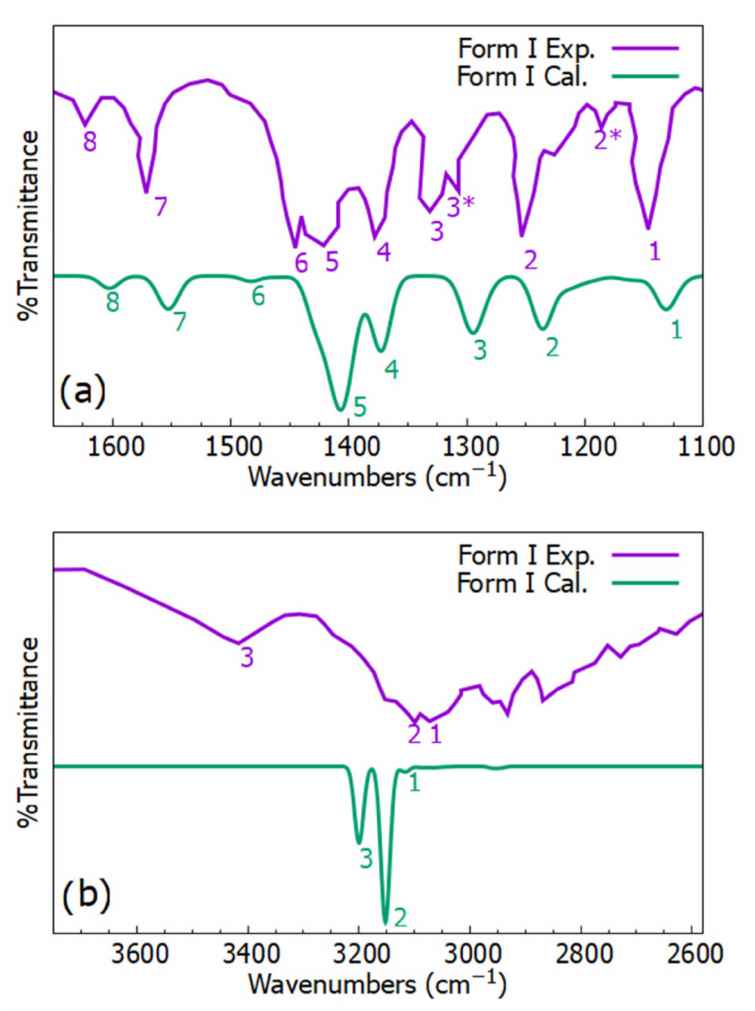
Figure 4. FT-IR spectra of triclabendazole form I at frequencies ( a ) from 1100 cm − 1 to 1600 cm − 1 and ( b ) from 2600 cm − 1 to 3600 cm − 1 . The purple curve represents experimental (Exp.) results [12] which were conducted at atmospheric pressure and room temperature. The green curve represents calculated (Cal.) results, which were obtained at atmospheric pressure and a temperature of 0